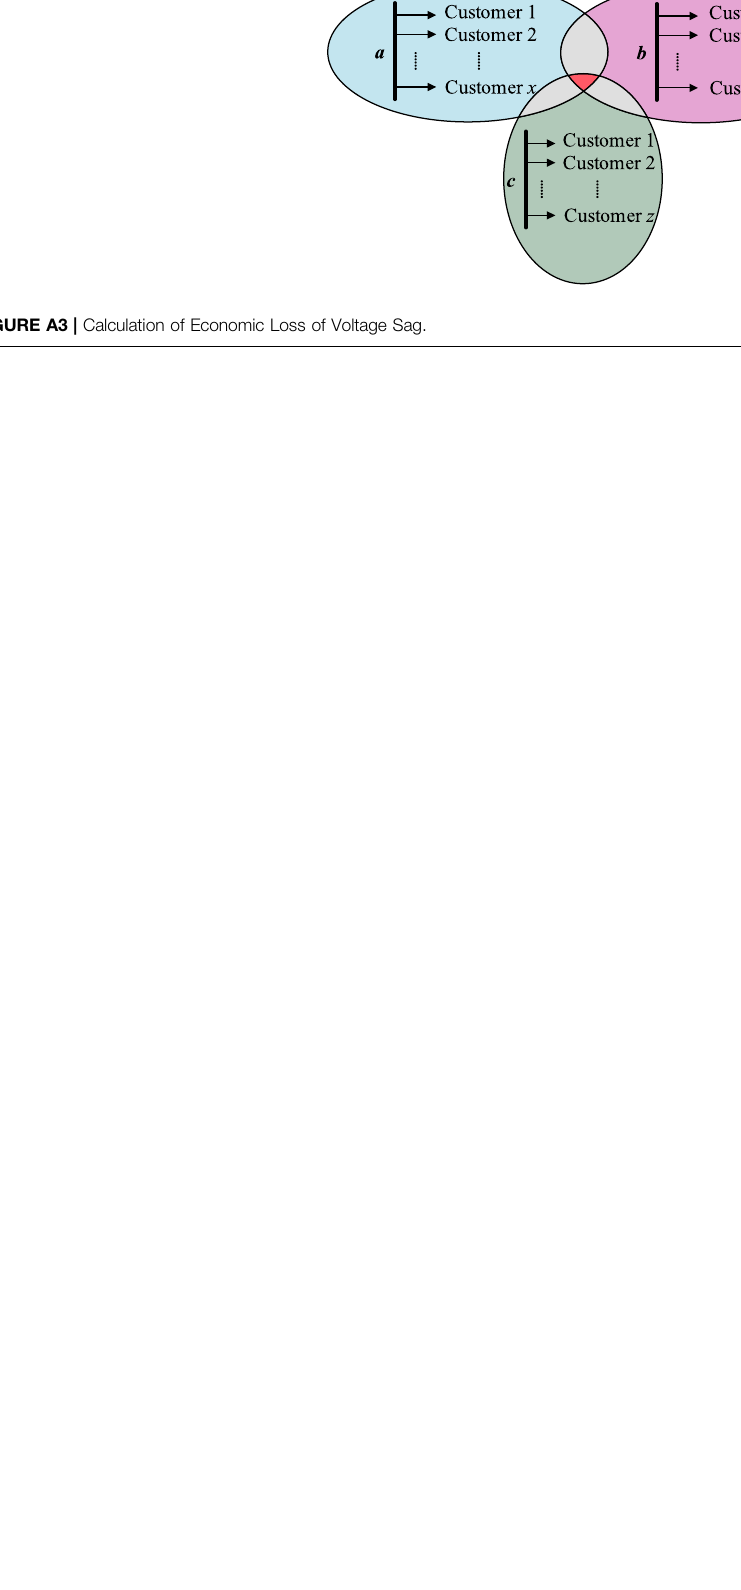
Frontiers in Energy Research |